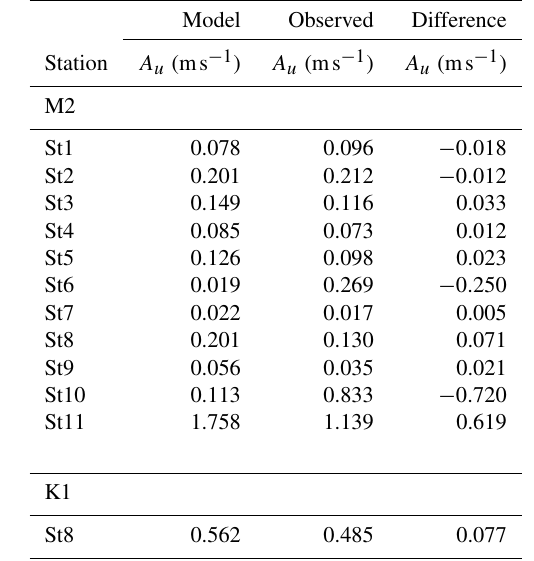
Table 2. Amplitude of modeled and observed tidal velocity for M2 and K1 tidal constituents. The difference is given as model minus observation ( M − O ). Observations are collected from Table 3 of Moe et al. (2002) (also displayed in Fig.